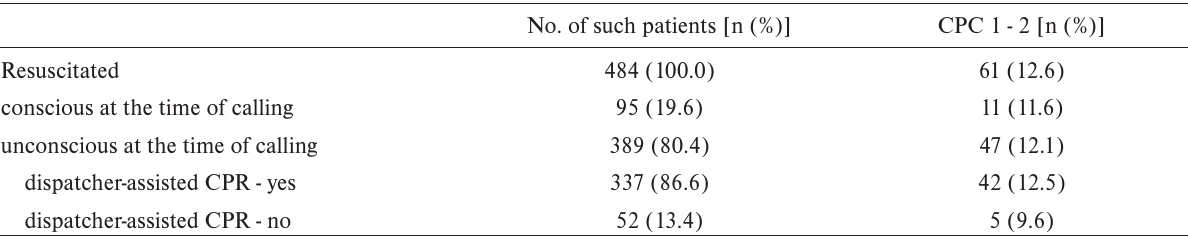
Table 1. Dispatcher-assisted